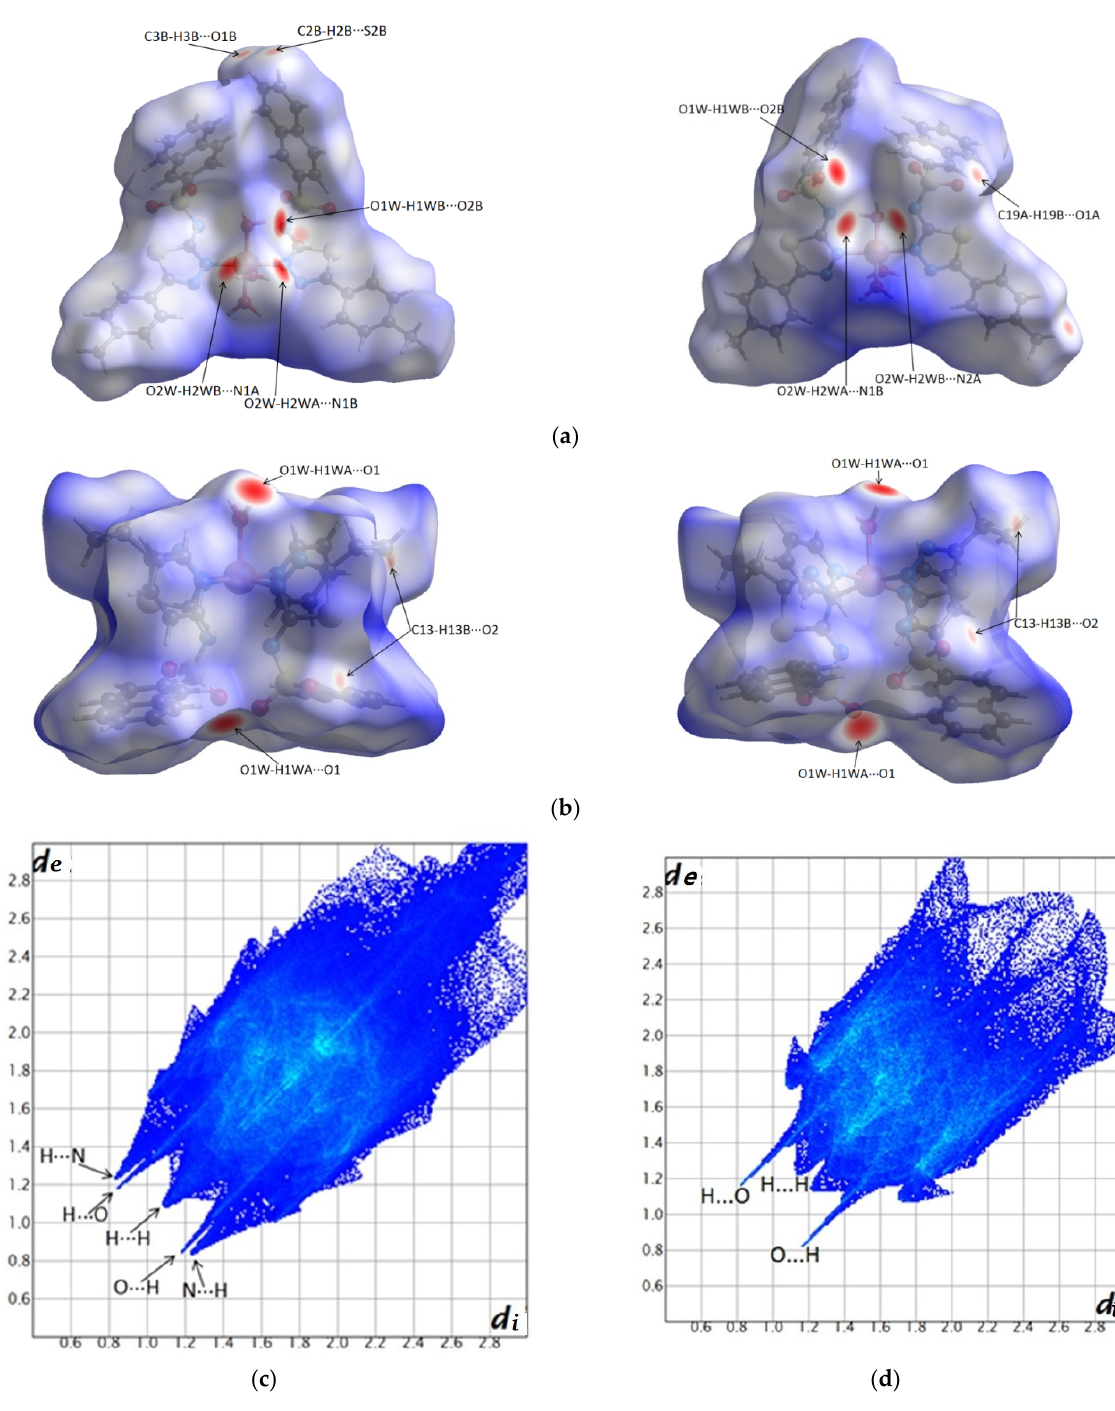
Figure 10. Front and back perspectives of the Hirshfeld surfaces mapped with d norm displaying the intermolecular contacts referred to in Table S3 in the Supplementary Material: C1 ( a ) and C2 ( b ). Surfaces are represented with the color scale as follows: − 0.44 (red) to 2.9 (blue) for C1 and − 1.27 (red) to 1.78 (blue) for C2 ; fingerprint plots of C1 ( c ) and C2 ( d ). The geometries of the hydrogen bonds and other interactions are detailed in Table S3 in the Supplementary Material, which are further represented by arrows on the Hirshfeld surfaces (Figure 10) (see Hirshfeld surfaces and fingerprint plots analysis section).